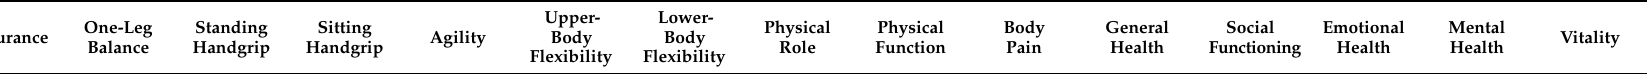
Table 2. Correlation between physiological abilities, Mediterranean dietary adherence, and SF-36